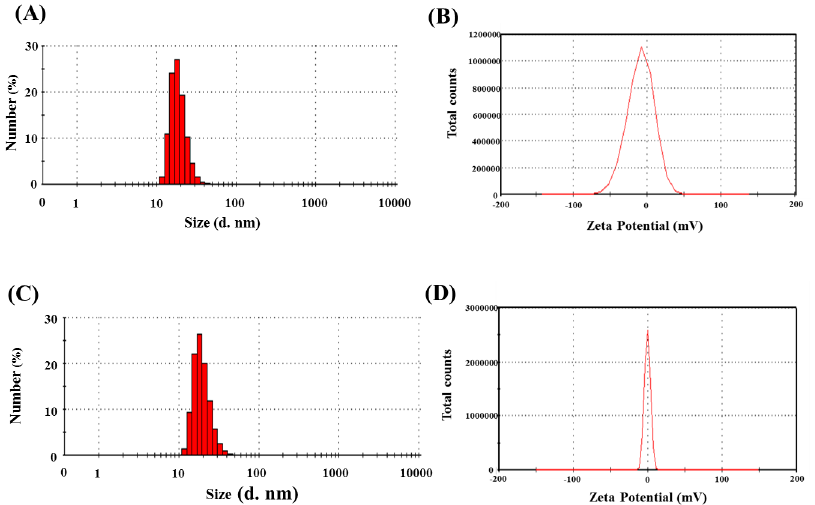
Fig 2. Dynamic light scattering (DLS) and zeta potential analysis of the MnMEIO-PEG (A) and Gd-MnMEIO (B) particles.